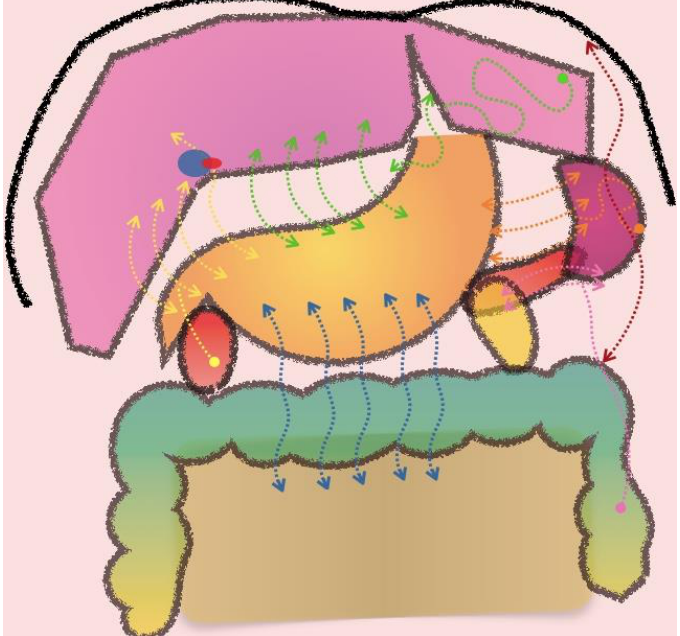
Figure 6. Patterns of peritoneal spread depending on the location of the primary tumour. Hepato- duodenal ligament (yellow arrows). Gastrohepatic ligament (green arrows). Gastrosplenic ligament (orange arrows). Splenorrenal ligament (pink arrows). Gastrocolic ligament (blue arrows). Frenocolic ligament (red arrows).